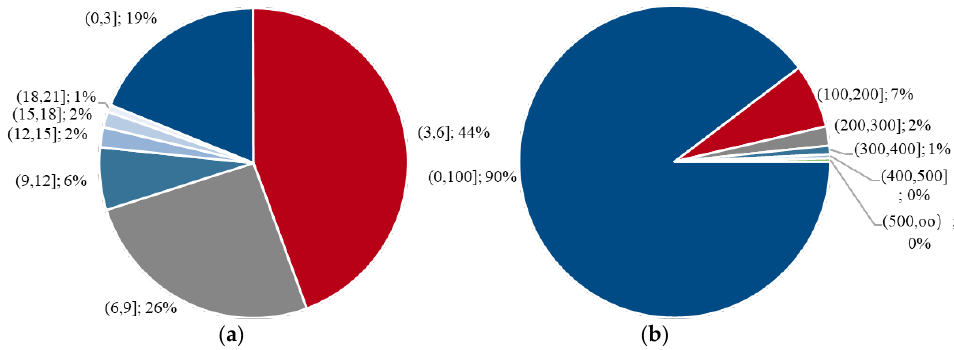
Figure 9. Analysis of output deviation and regulating energy ( a ) The output deviation between AGC command and units (MW) ( b ) Energy required for each regulation (kWh).